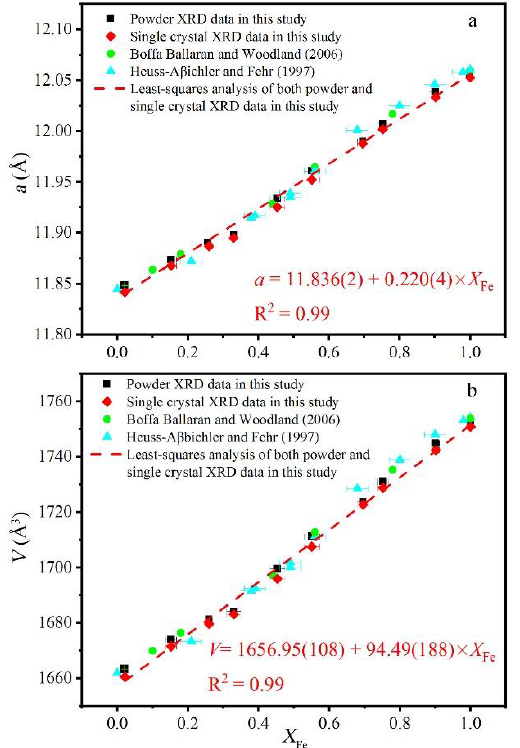
Figure 3. Effect of composition (x) on ( a ) unit-cell parameters and ( b ) unit-cell volume of grossular–andradite solid solution. The equations shown are fitted by least-squares analysis.